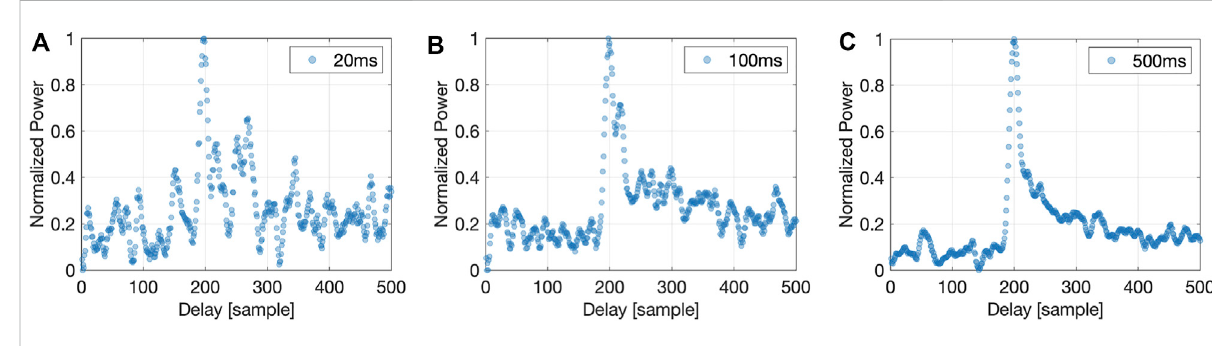
FIGURE 4 Waveform of the re fl ected signal with different incoherent integration of (A) 20 ms, (B) 100 ms, and (C) 500